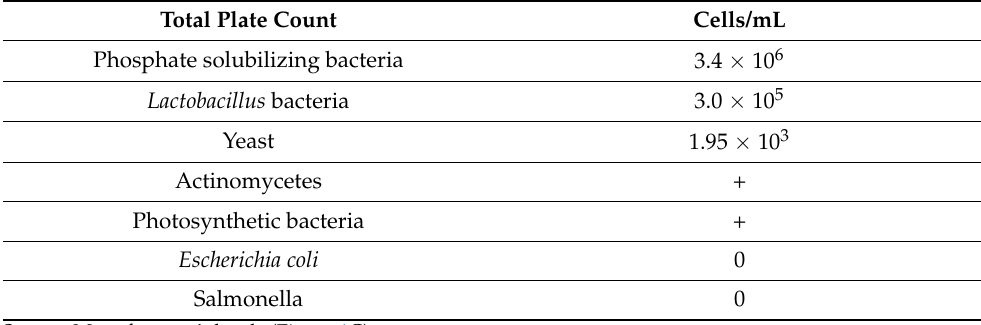
Table 1. Microbial count of the effective microorganism-4 (EM4) solution. Total Plate Count